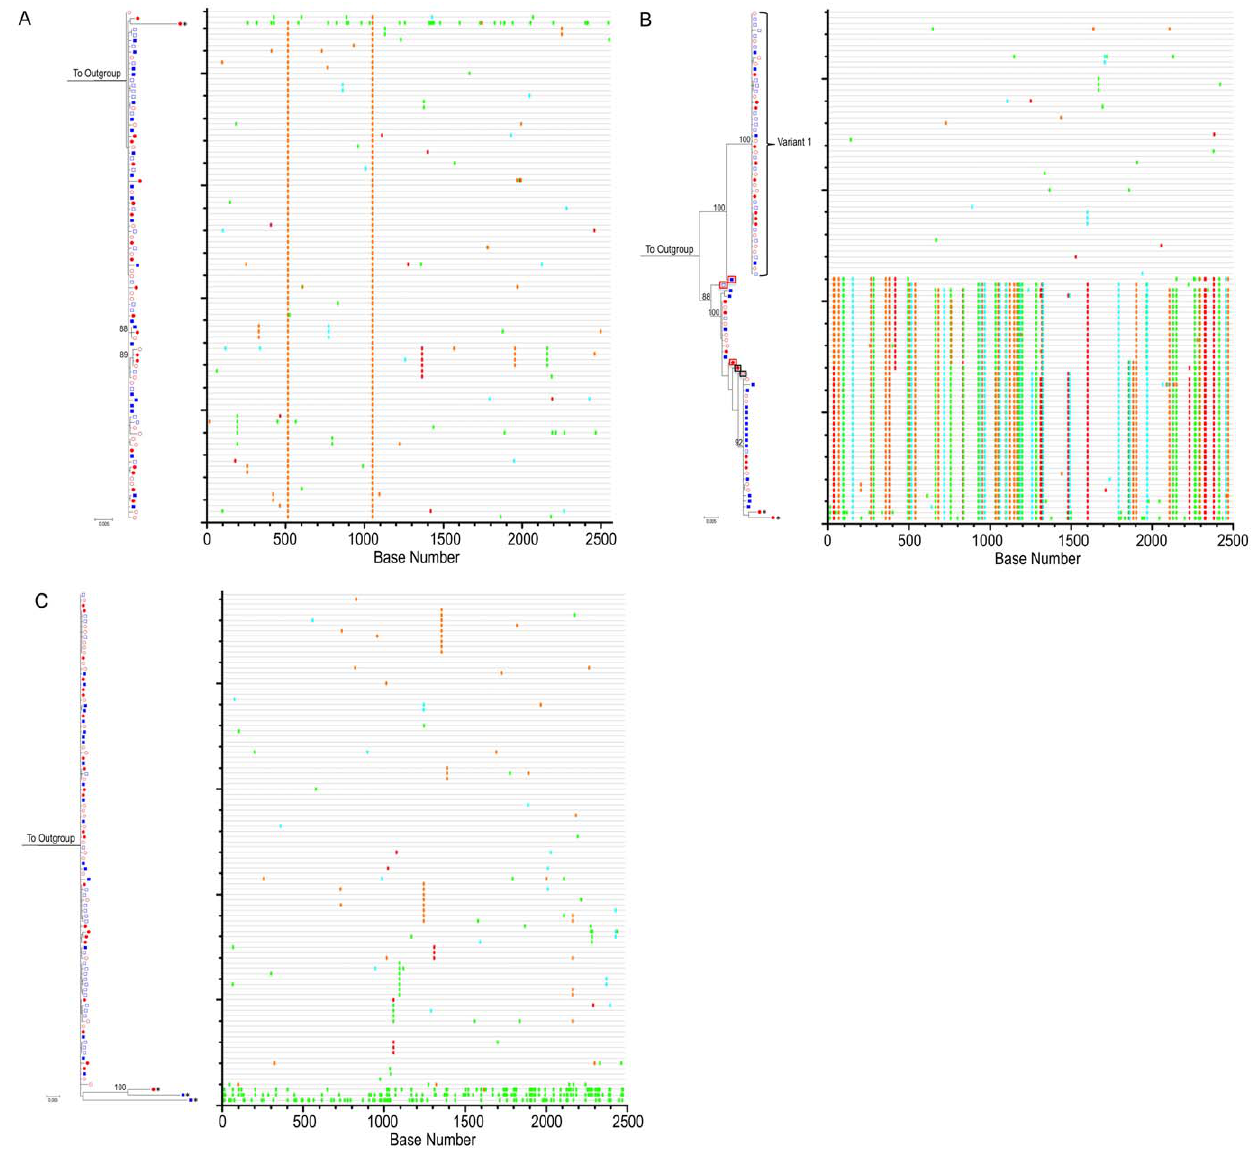
Figure 4. HIV-1 env phylogenies do not suggest measurable evolution on suppressive cART. ML tree of SGA sequences from participants (A) HIA (B) IIA and (C) LIA. For all panels, PBMC time point # 1 (open red circles), PBMC time point # 2 (closed red circles), GALT time point # 1 (open blue squares) and GALT time point # 2 (closed blue squares) are shown. 1000 bootstrap replicates were run and Bootstrap values over 85% are shown. The scale bar represents 0.005 nucleotide substitutions per site. HXB2 was used as an outgroup. Starred sequences represent those determined to be hypermutated. To the right of each ML tree is the corresponding Highlighter plot (outgroup sequence not shown). Individual nucleotide changes from a master sequence (TP1 sequence at the top of the ML tree) are shown. A-green; T-red; G-orange; C-light blue. For participant IIA, phylogenetic analysis reveals acquisition of more than one variant with in-vivo inter-lineage recombinants. Sequences surrounded by boxes represent HIV-1 env recombinants (red boxes denote a sequence p value of p , 0.05 in Recco; black boxes denote a sequence p value of p , 0.25 in Recco).